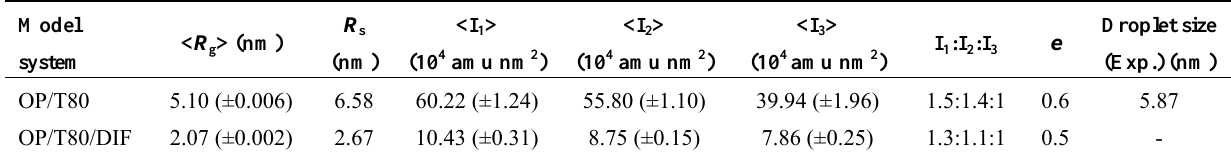
Table 1. A Summary of the averaged R the OP/T80 and OP/T80/DIF models for the last 500 ps of both